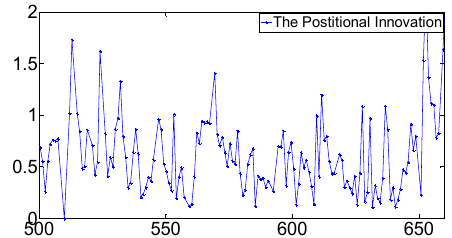
Figure 15. The Positional Innovation of BLE/INS/NHC integration in underground parking